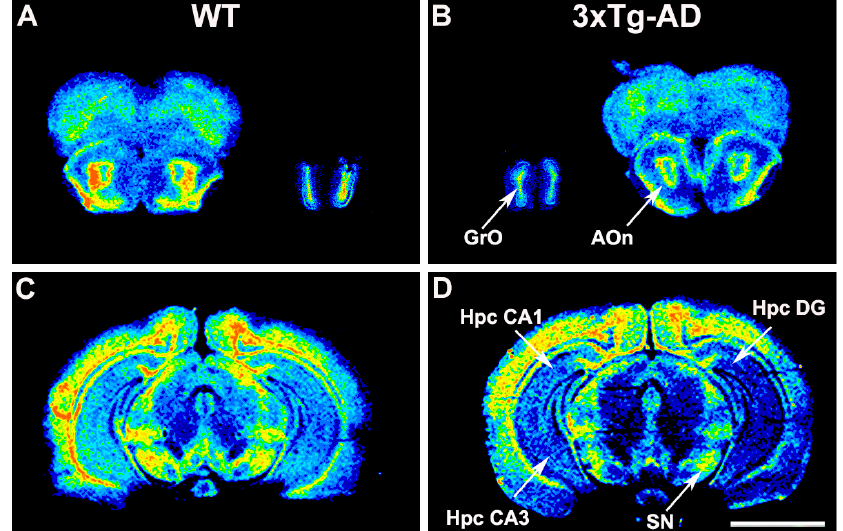
Figure 3. Representative autoradiograms of WT ( A , C ) and 3xTg-AD ( B , D ) mice in coronal brain sections that show [ 35 S]GTP γ S binding evoked by CYM5442 (10 − 5 M), accounting for S1P 1 receptor activity. The S1P 1 receptor activity was reduced in the rhinencephalon, hippocampus, and substantia nigra from 3xTg-AD mice. Scale bar = 4 mm. GrO: granular olfactory bulb, AOn: Anterior olfactory nucleus, Hpc DG: hippocampus dentate gyrus, Hpc CA1: hippocampus CA1, Hpc CA3: hippocampus CA3, SN: Substantia nigra.